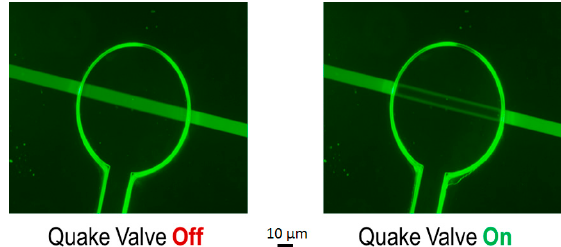
Figure 8. Microfluidic neuron device.